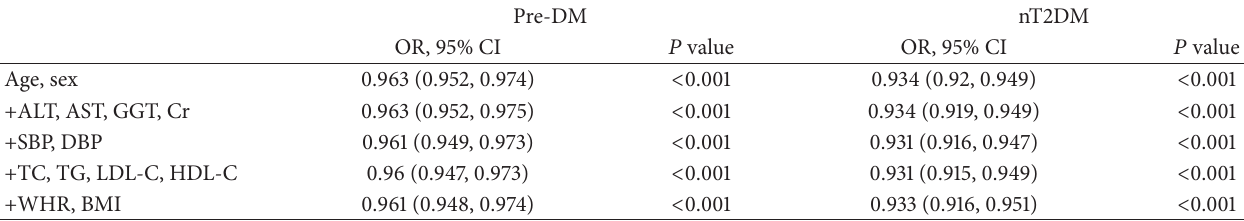
Table 3: Multiple logistic regression analyses of plasma CTRP-3 levels among various groups.